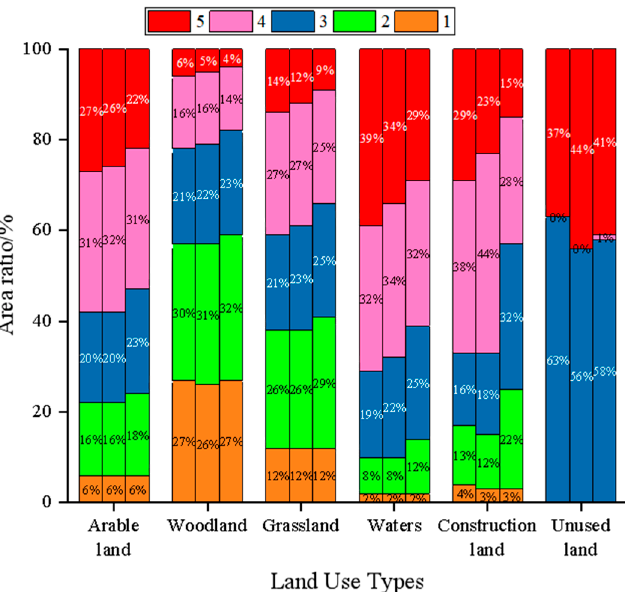
Figure 8. Distribution of ecological risks by land-use types. Note: 1, 2, 3, 4, and 5 represent low-risk, low-medium-risk, medium-risk, medium-high-risk, and high-risk, respectively. The corresponding year of ecological risk for each land use type is 2000, 2010, and 2018 from left to right.